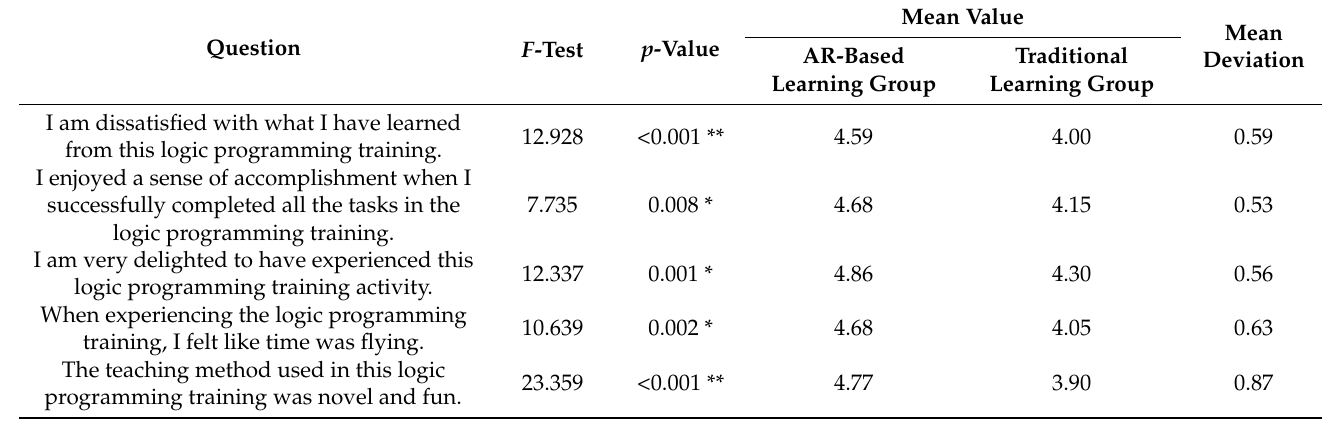
Table 12. Level of significance for each question in the Satisfaction